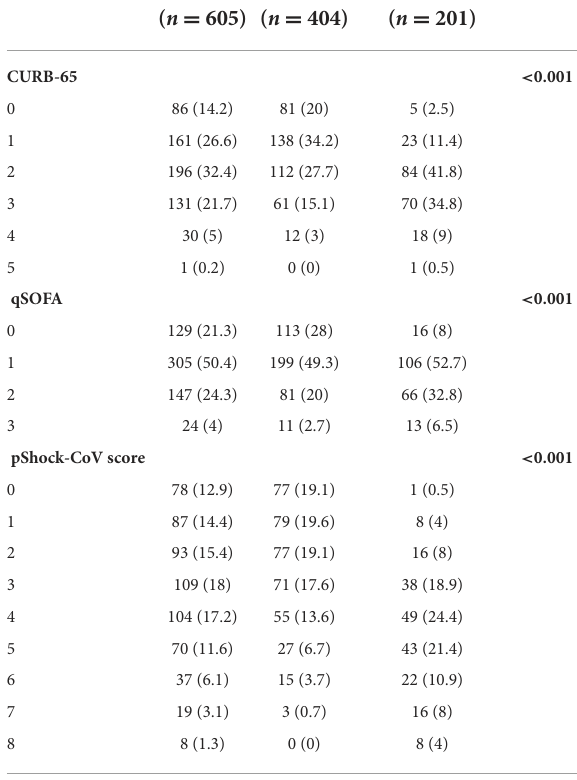
TABLE 2 Prognostic scores in cohort stratified by mortality. Characteristics General Survivors Non-survivors p -value